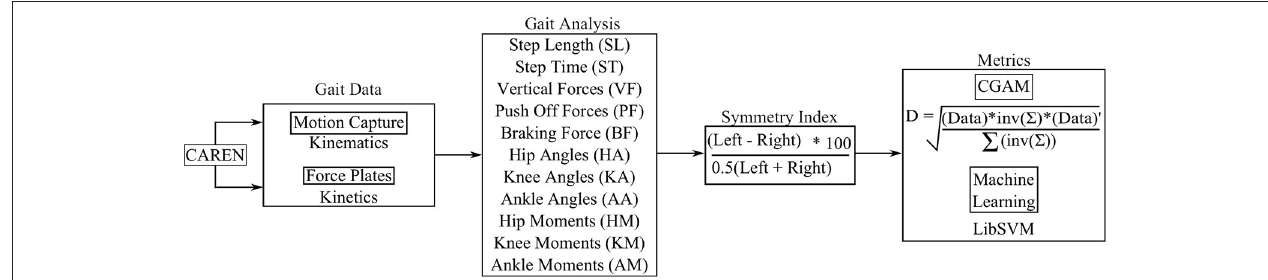
FIGURE 4 | Procedure to acquire gait metrics.